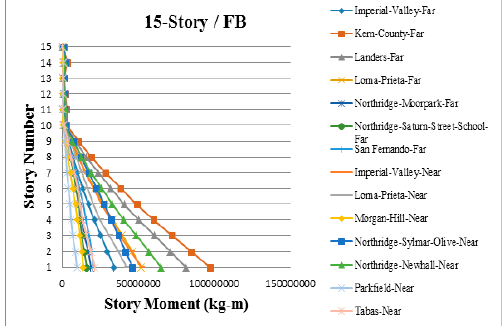
Figure A17. Peak story moments for 15-story fixed-base building.